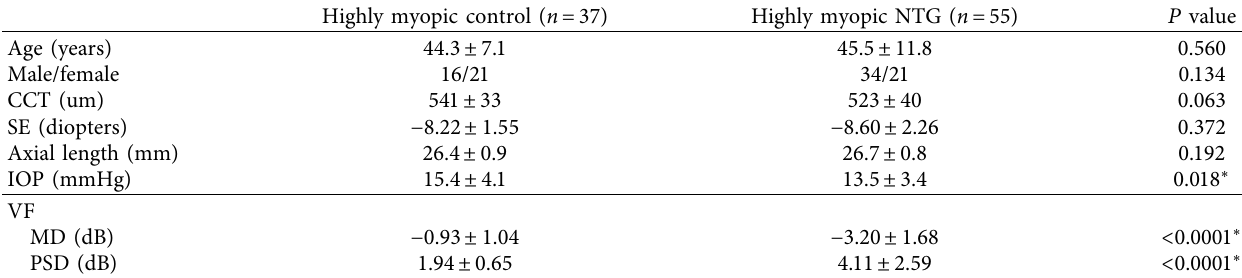
Table 1: Demographic data of highly myopic control subjects and highly myopic normal-tension glaucoma patients. Highly myopic control ( n � 37)